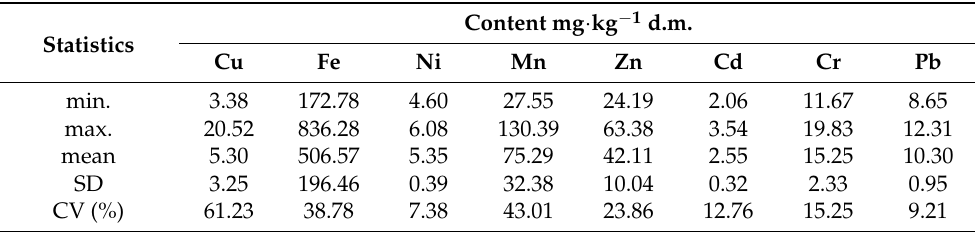
Table 13. The content of heavy metals in the aboveground part of Daucus carota subsp. sativus growing in 24 allotment plots of Gorz ó w